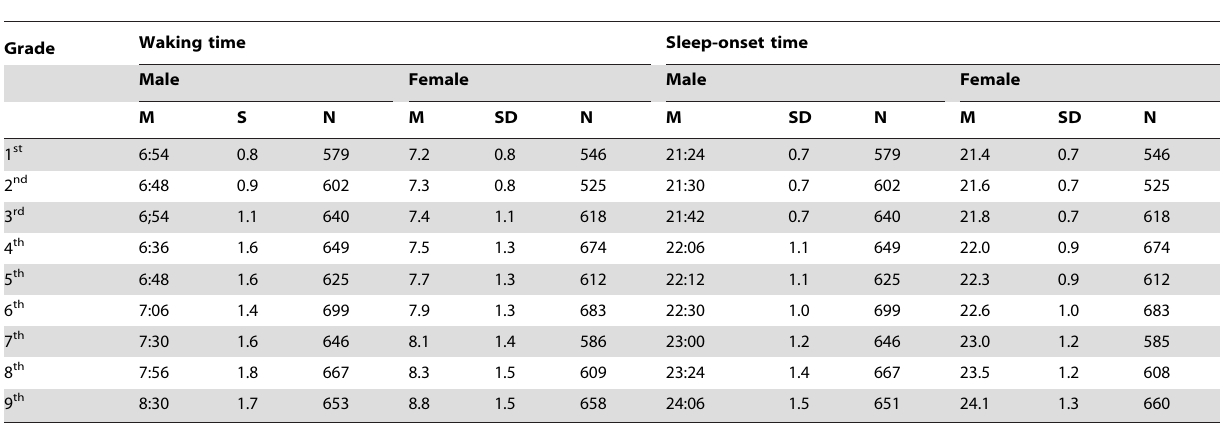
Table 3. Waking and sleep-onset times on